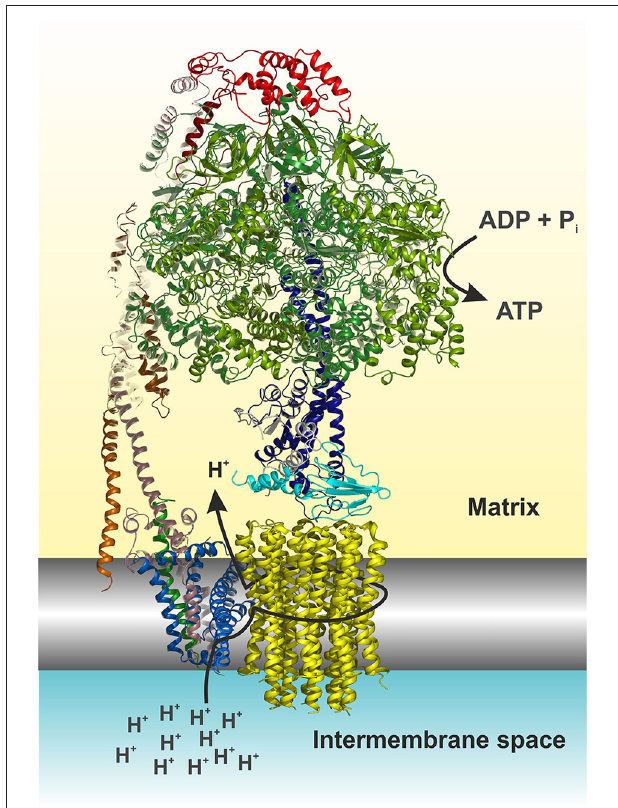
FIGURE 1 | Cartoon representation of the yeast F 1 F o ATP synthase. The view is horizontally to the membrane shown in grayscale. The structure was drawn according to (Hahn et al., 2016, PDB code 5FL7). For simplicity the structure is shown without subunits e , f , g , I, and a truncated subunit b . The figure was made in Pymol (The PyMOL Molecular Graphics System, Version 0.99, Schrödinger, LLC), using the following color code: α , forest; β , split pea; γ , density; δ , cyan; ε , white; OSCP , red; b ( = 4 in yeast), dirty violet; d , orange; h , salmon; 8 , green; a , blue; c -ring, yellow. The arrows indicate the path of protons (see also Figure 4 ) and nucleotide conversion. For details see